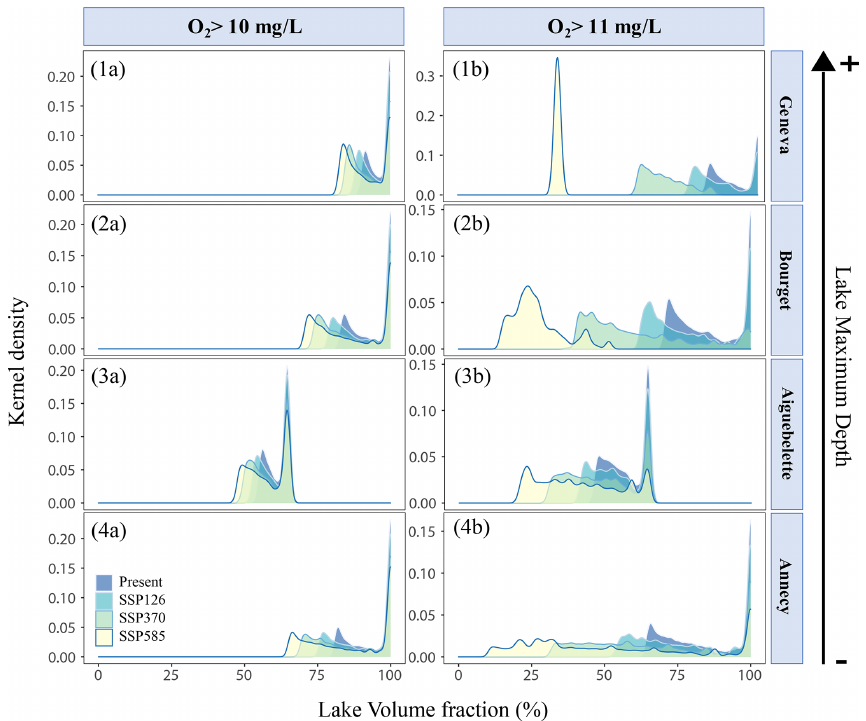
Figure 11. Lake volume fraction with oxygen solubility exceeding two thresholds – 10mgL − 1 (a) and 11mgL − 1 (b) – calculated from sim- ulated water temperature profiles and bathymetry in Lake Geneva (1), Bourget (2), Aiguebelette (3) and Annecy (4). Kernel density estimates of daily average lake volume fraction over the present (2000–2010) and the future (2090–2100) predicted by the three scenarios (SSP126, SSP370, and